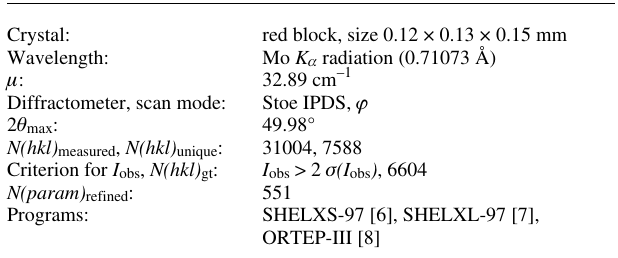
Table 1. Data collection and handling.